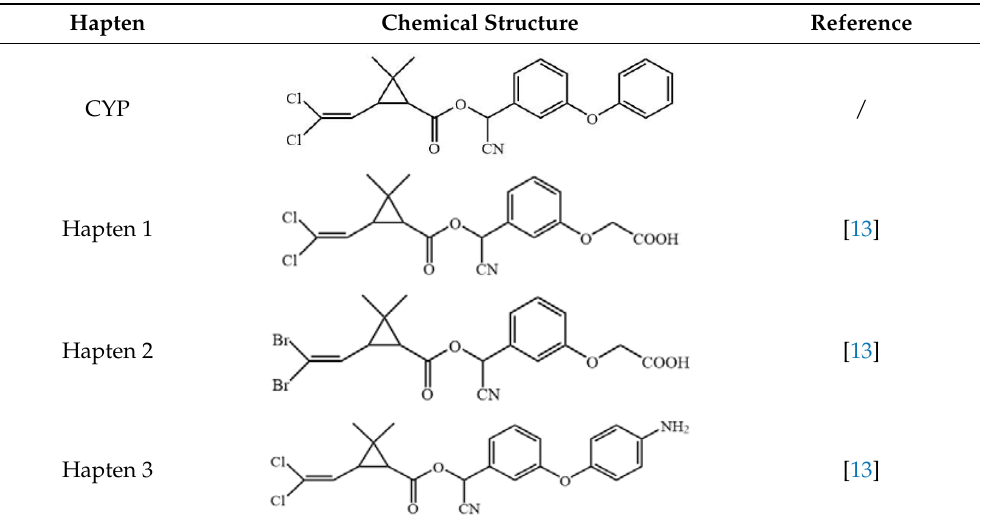
Table 1. The chemical structures of haptens of cypermethrin. Hapten